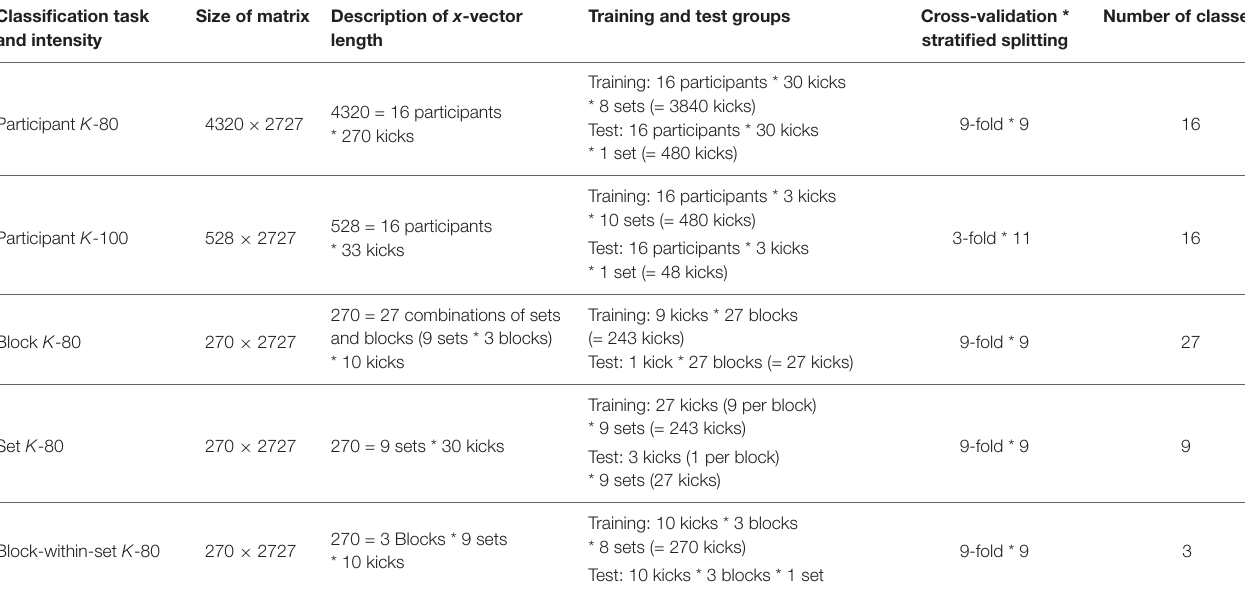
Kicks for classification are based on the left- or the right-footed kicks; 2727 = 1 leg ∗ 27 joint angle waveforms ( x-, y-, and z-plane ∗ 9 joint angles) ∗ 101 data points.